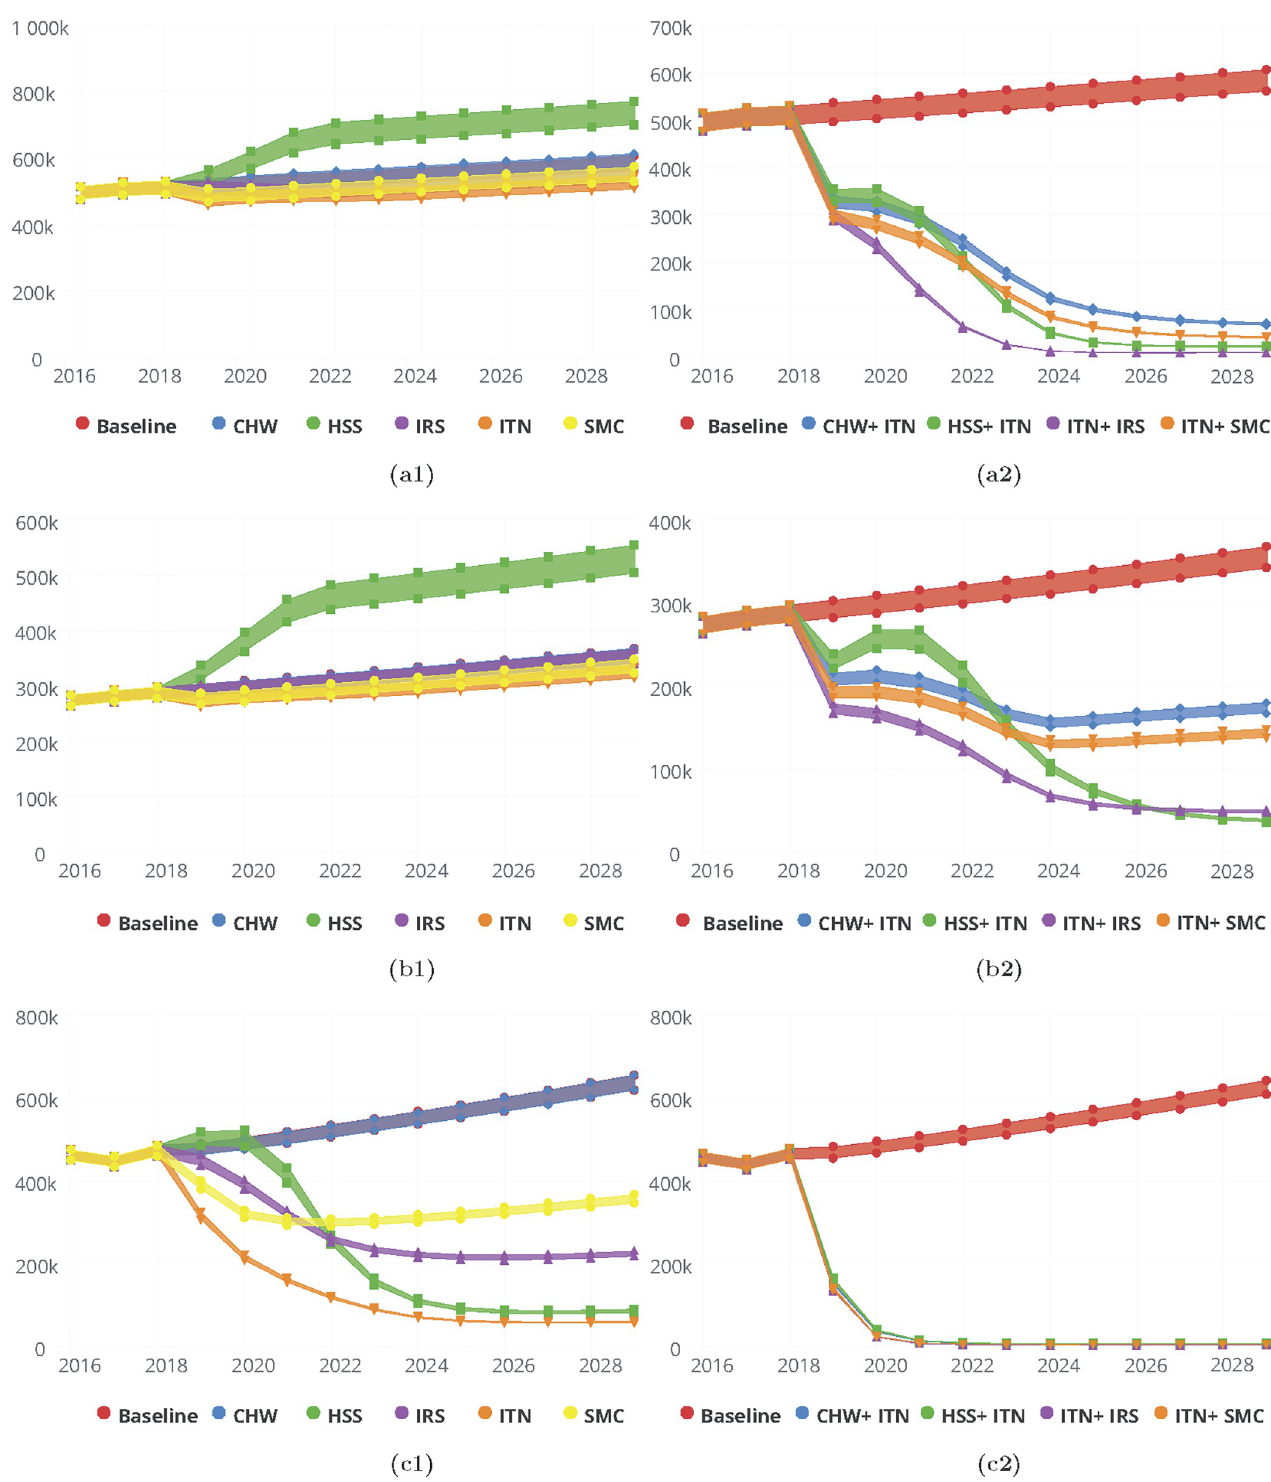
Fig 7. Predictions for malaria incidence for various intervention packages, singly (a1-c1) for Community Health Worker (CHW), Health System Strengthening (HSS), Indoor Residual Spraying (IRS), Insecticide Treated bednets (ITN) and Seasonal Malaria Chemoprevention (SMC) and in combination (a2-c2) for CHW/CHPS + ITN, HSS + ITN, ITN + IRS and ITN + SMC for the Upper East (a1 and a2) Upper West (b1 and b2) and Northern (c1 and c2) Regions respectively.